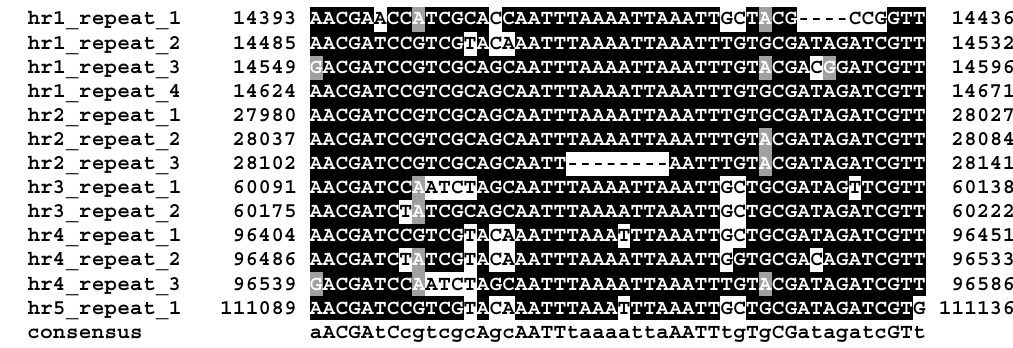
Figure 4. OpbuNPV-MA homologous region ( hr ) unit repeats. Nucleotide positions of the repeats in the genome sequence are indicated. Identical nucleotides occupying >50% of aligned positions are shaded in black, and nucleotides of the same class as conserved nucleotides (containing either a purine or pyrimidine base) are shaded in gray. Uppercase letters in the consensus sequence denote nucleotides in the alignment with completely identical residues, and lowercase letters denote positions in the alignment with a majority of identical residues.